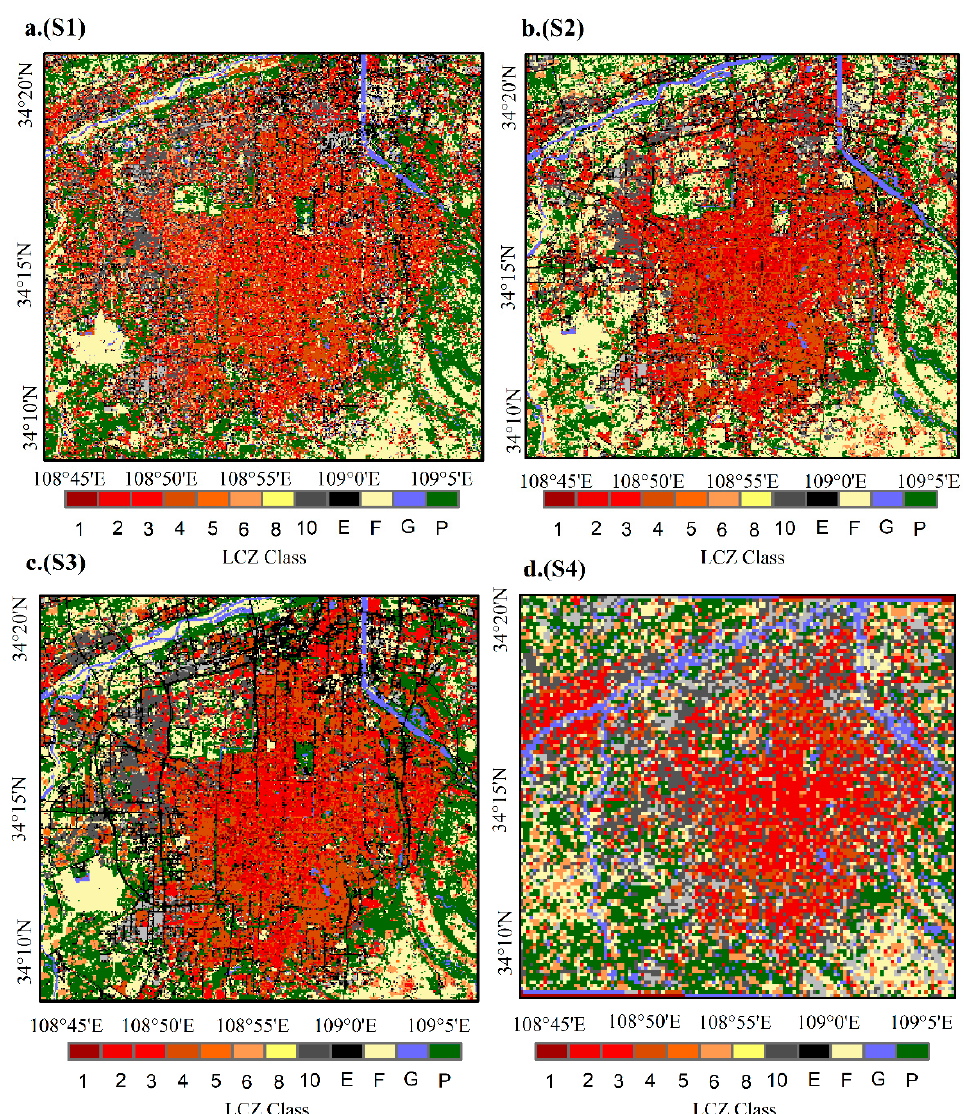
Figure 6. LCZ map of scheme S1 ( a ); LCZ map of scheme S2 ( b ); LCZ map of scheme S3 ( c ); LCZ map of scheme S4 ( d ).